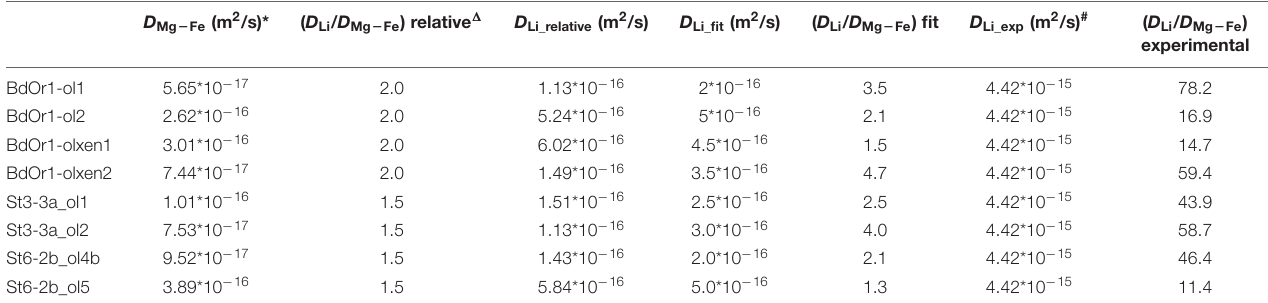
* Calculated at P = 500 Pa, T = 1250 ◦ C, fO 2 = NNO-2, crystallographic orientation, X Fe and concentration profiles from Oeser et al. (2015). (cid:49) (D Li /D Mg − Fe ) relative is calculated by multiplying the actual diffusivity of Mg–Fe at 1250 ◦ C and recalculated to the crystallographic orientation of the profile, with Ã L i/Ã Mg − Fe dcalculated with approach (2) according to Eq. (4). # Experimentally determined D Li calculated at 1250 ◦ C according to Eq (3) from Dohmen et al. (2010).